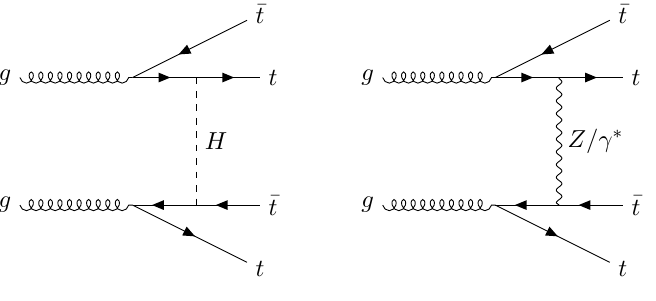
Figure 1 . Representative leading order tree-level Feynman diagrams of O ( α 2 ( left ) and the q ¯ q -initiated ( right ) SM four-top production at the LHC.